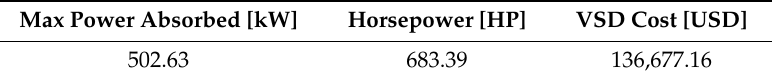
Table 3. VSD cost estimation for Case 2.